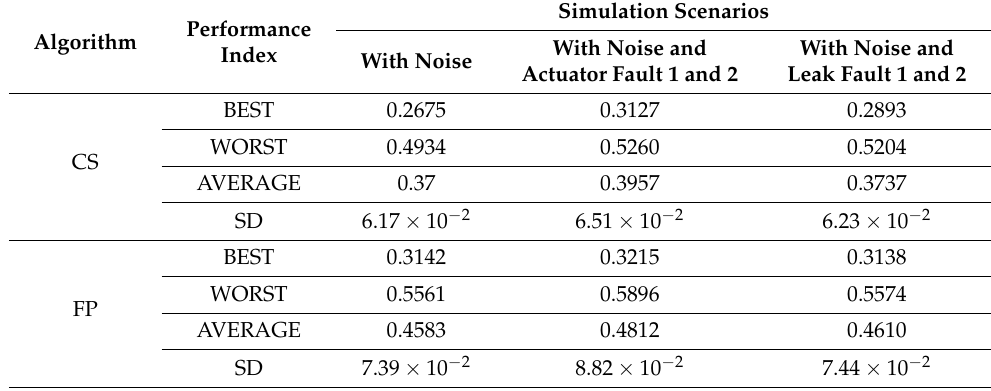
Table 7. Results of metrics of Root Mean Square Error (RMSE) values to found by fuzzy CS and fuzzy FP algorithm using ST2FIS.